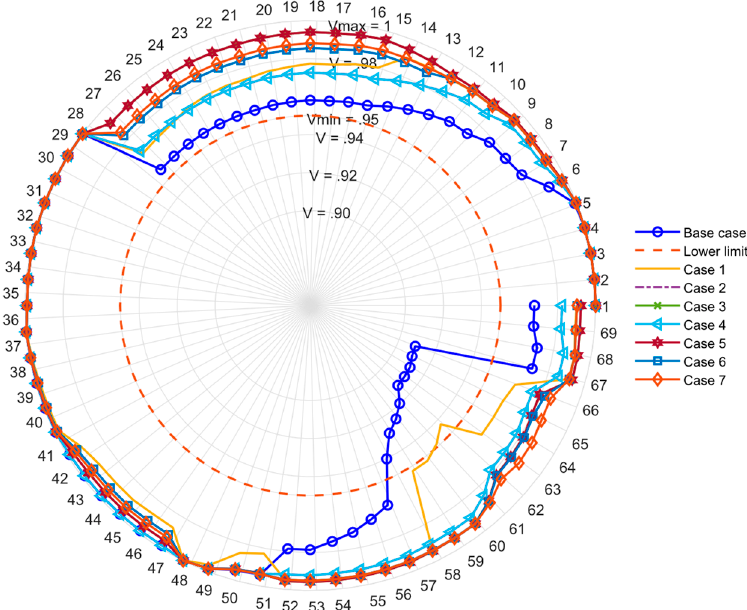
Figure 10. Voltage magnitude profile of the 69-node test DS for all cases.